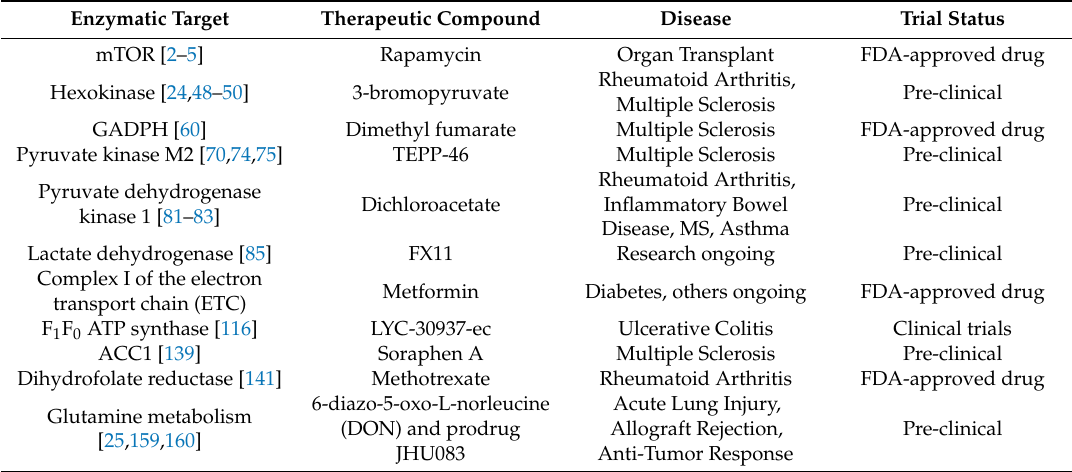
Table 1. A sample of potential and currently used therapeutics targeting metabolic enzymes to modulate